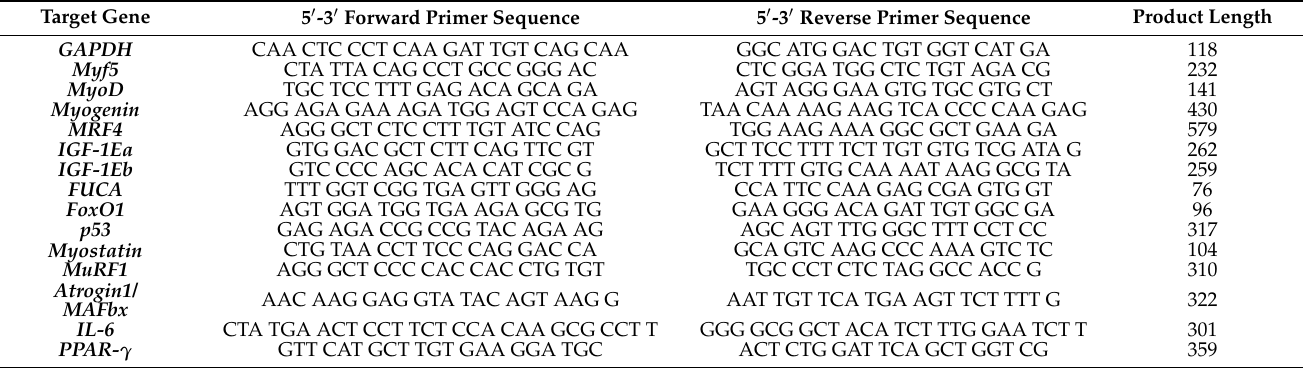
Table 1. The sequences of the specific sets of primers used for RT-PCR analyses. Target